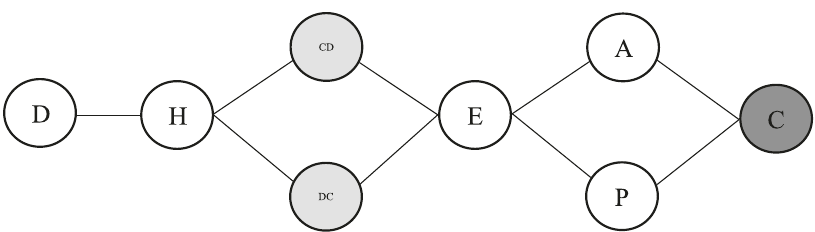
Fig. 1 The formalized structure of an emotional system in our AGI. The diagram respects the four distinct phases previously identi fi ed: ( a ) the generation of emotion for internal or external reasons; ( b ) the evaluation of the emotion; ( c ) the anticipation-prediction; ( d ) the action, i.e., the production of a series of actions in accordance with the previous moments.Our AGI system analyzes a set of data (D) that can derive from external reality, from other emotional systems, and from other parts of the brain and body. Using this set of data, the system elaborates causal hypotheses (H) based on some fundamental assumptions or beliefs. The “ heart ” of the system is the evaluation (E), or inference, which is realized through the causal diagram (CD) and the do-calculus (DC). The evaluation allows for the elaboration of predictions (P), actions (A), and counterfactuals (C).